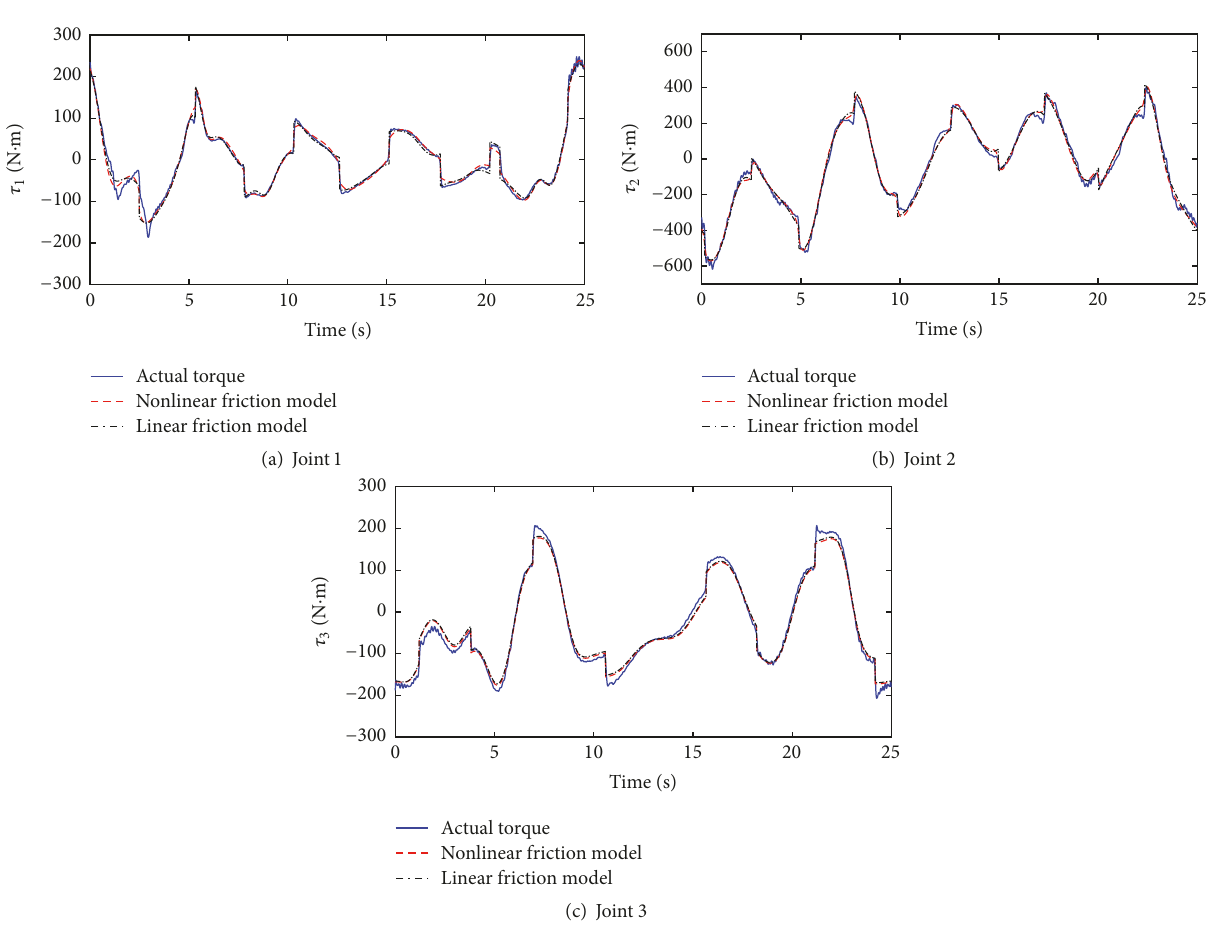
Figure 7: Comparison of the different friction